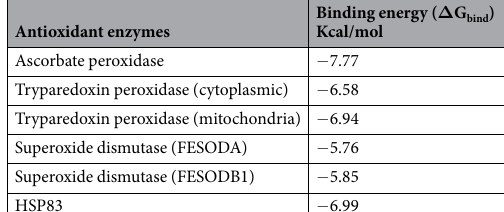
Binding energy ( Δ G bind ) Kcal/mol